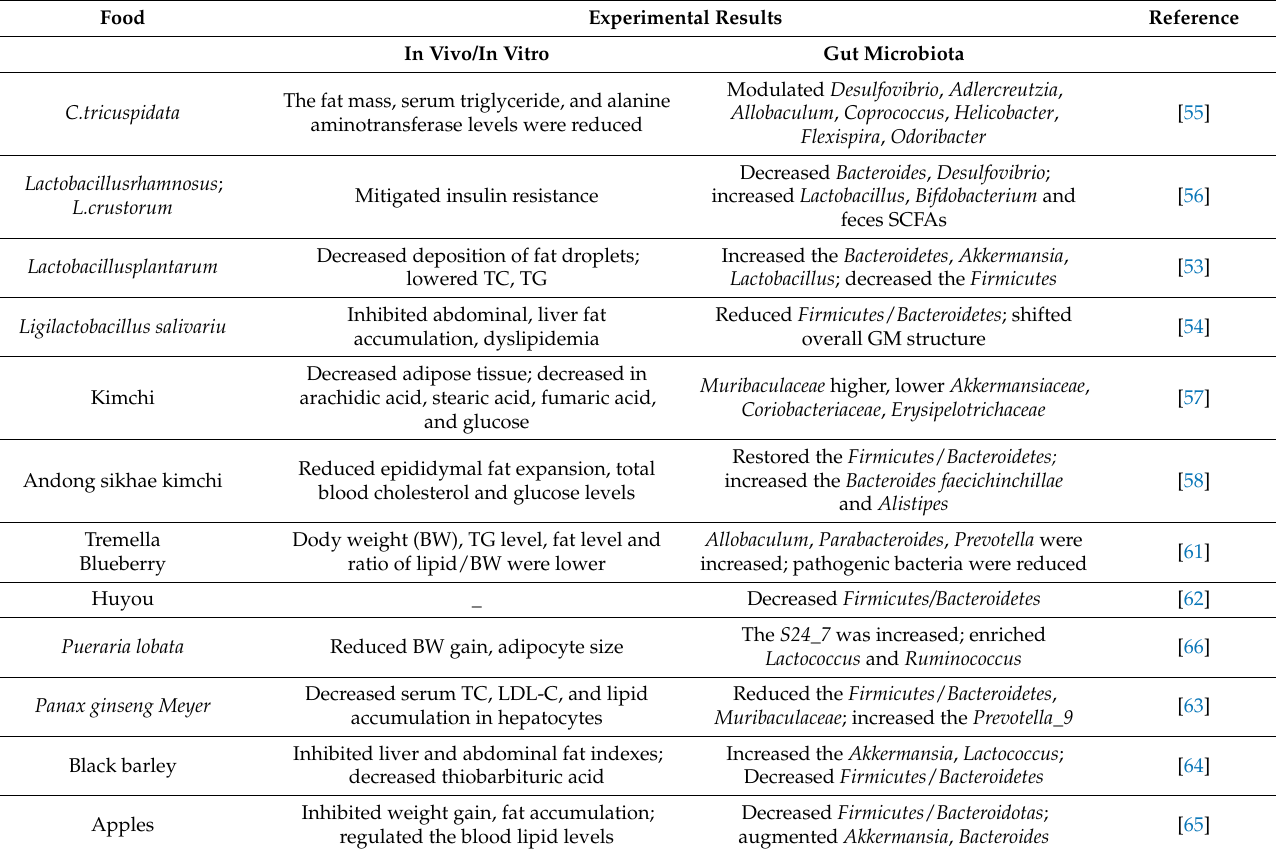
Table 3. Fermented food against obesity in vitro/in vivo based on gut